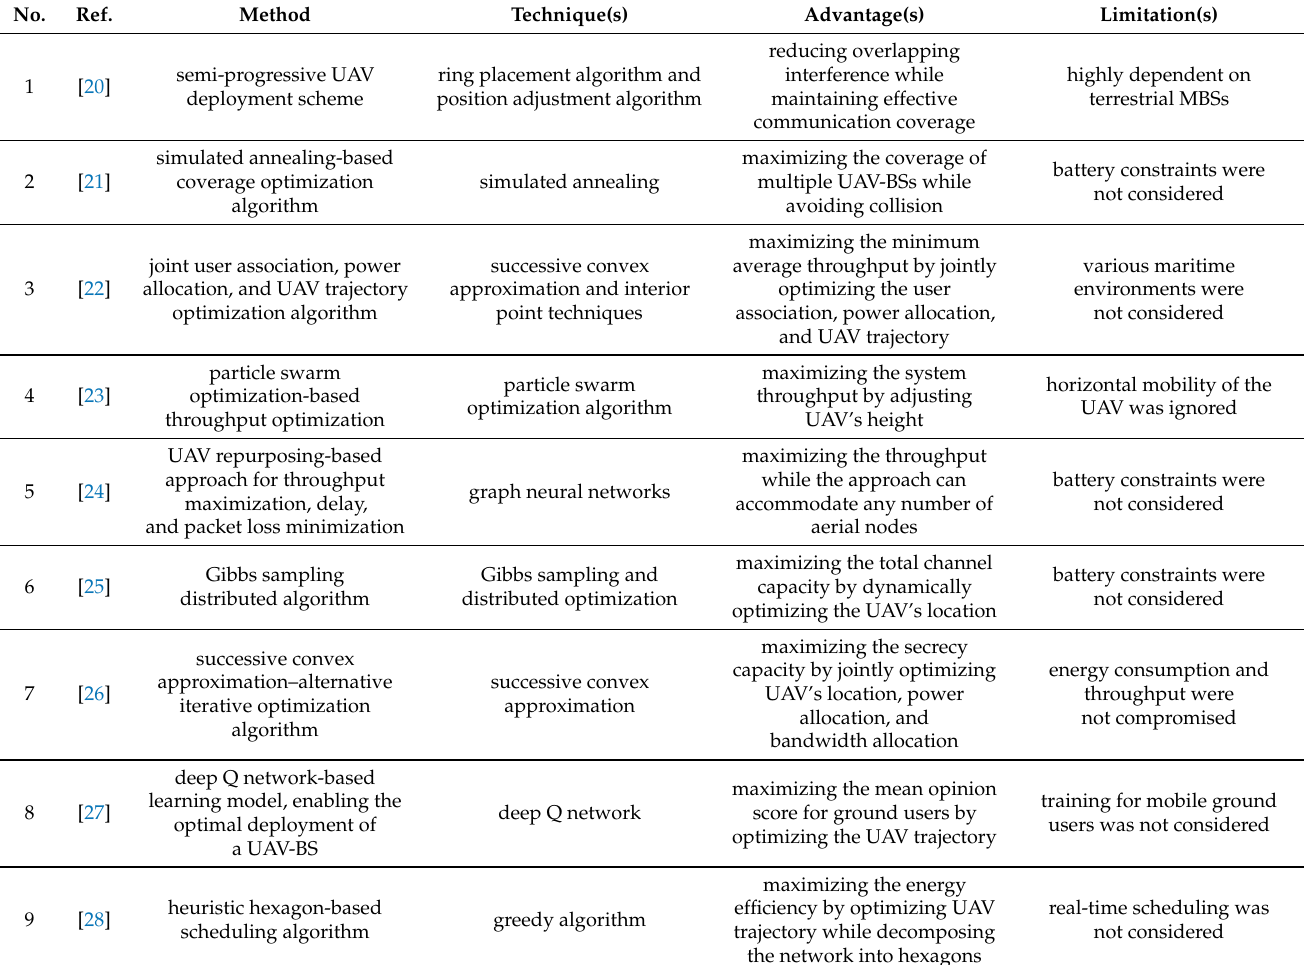
Table 1. Summary of related